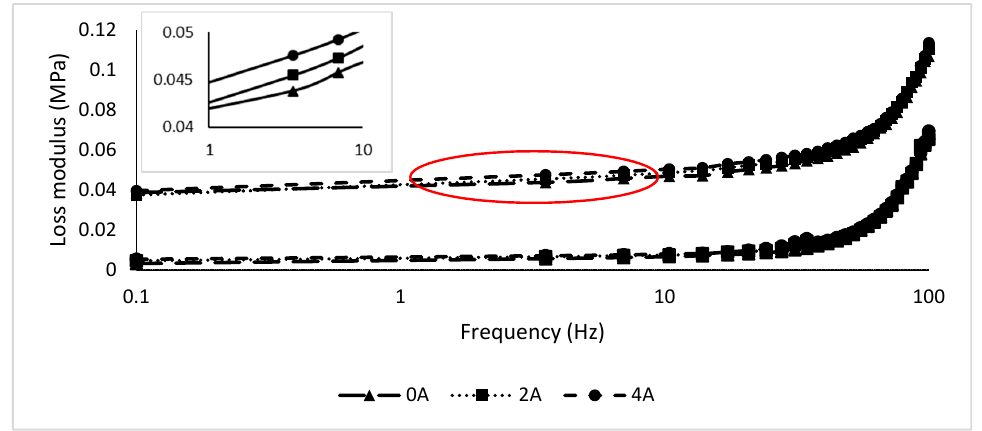
Figure 8. Loss modulus of MRE and Gr-MRE at different frequency amplitudes at magnetic fields of 0, 2, and 4 A.